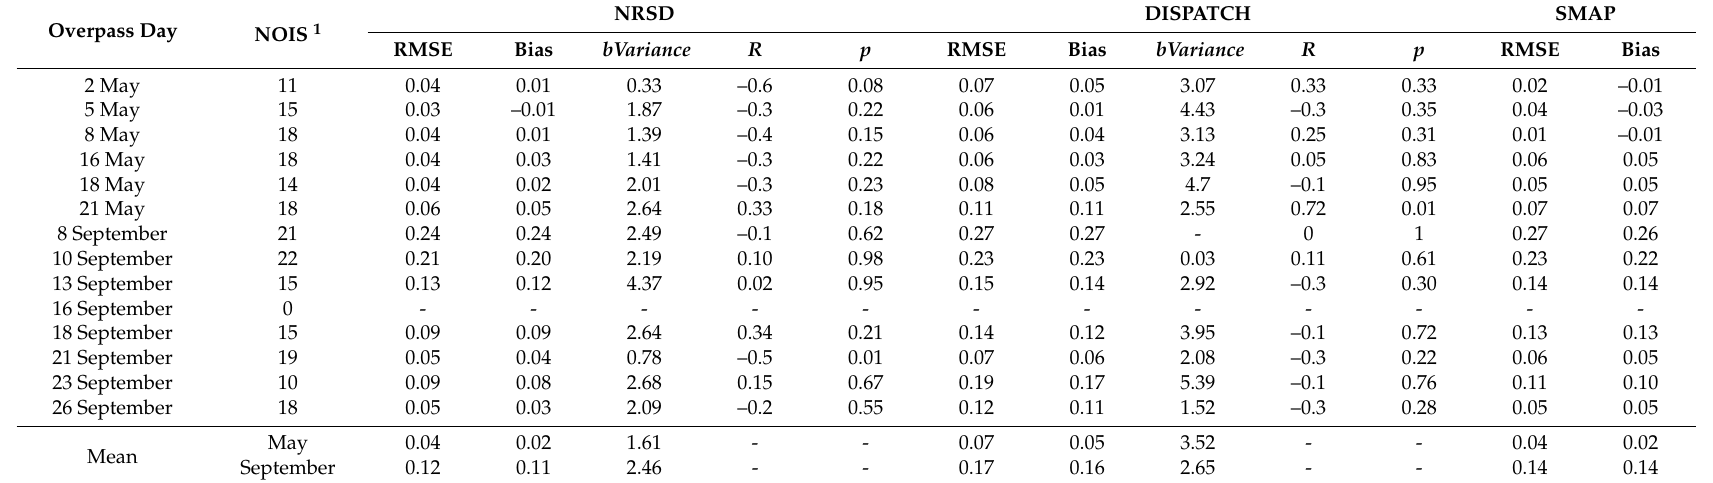
Table 2. Validation of NRSD-disaggregated soil moisture compared to DISPATCH-disaggregated, SMAP and in situ soil moisture. Overpass